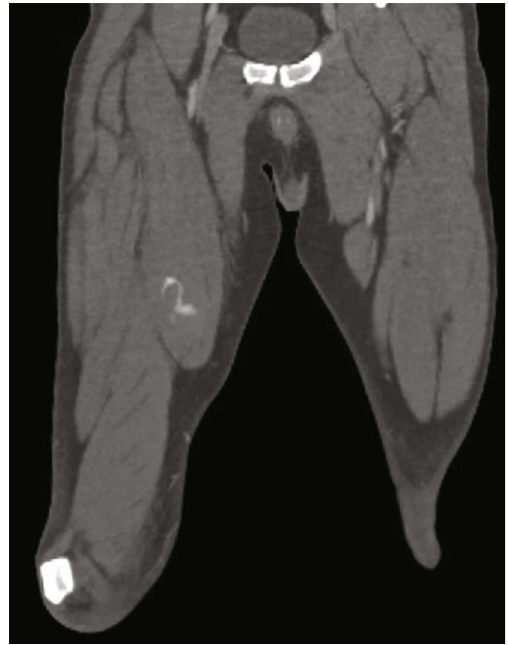
Figure 2: A coronal CTA image of bilateral thighs demonstrating a hematoma in the sartorius of the right